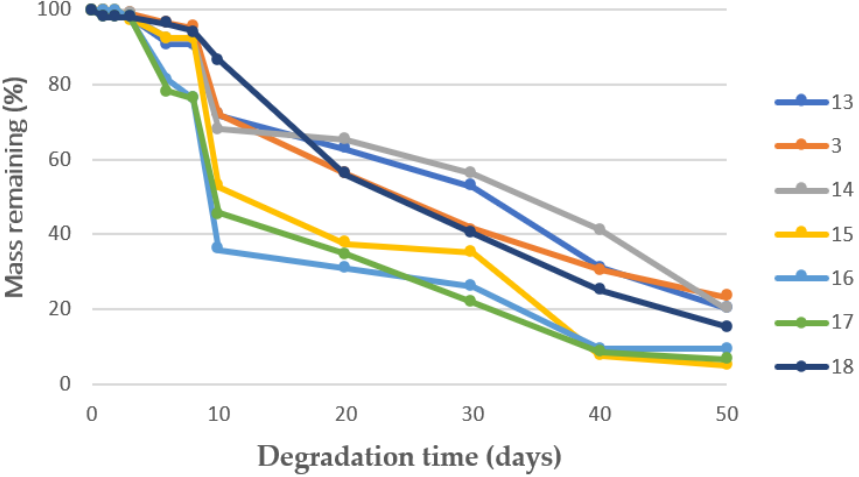
Figure 11. Mass remaining vs. degradation time in PBS solution of the scaffolds obtained after varying contact times.